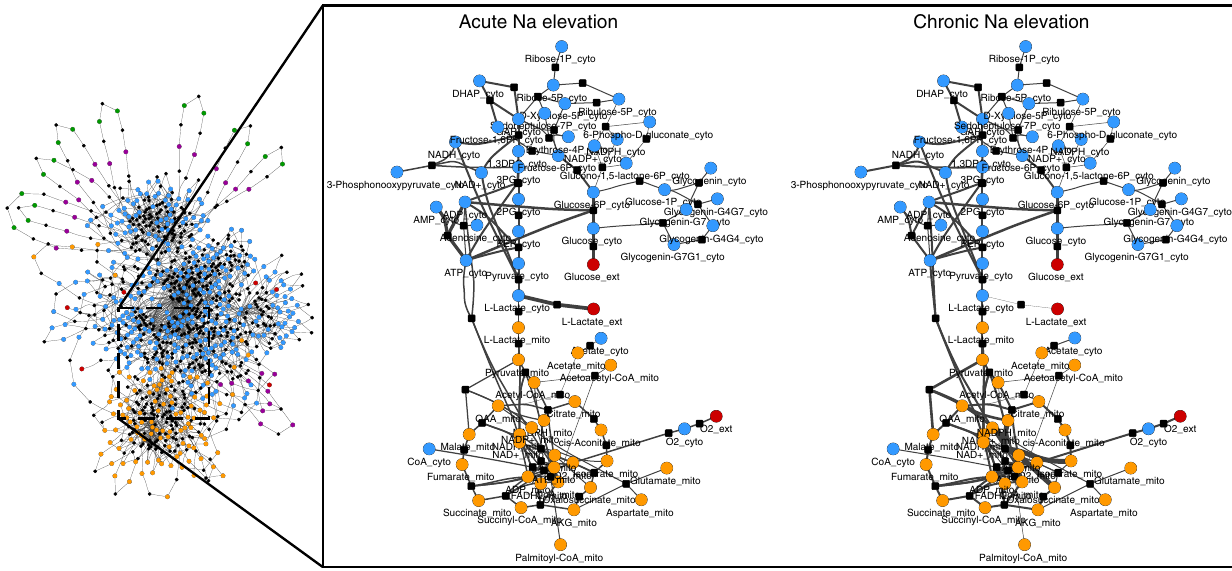
Fig. 6 CardioNet in silico metabolic fl ux changes in response to acute and chronic Na i elevation. Graph denotes estimated fl ux distribution in response to acute and chronic Na i elevation. The coloured nodes represent metabolites assigned to fi ve different compartments: extracellular space, cytosol, mitochondria, microsome, lysosome. The black square nodes indicate reactions; two reactions are linked by a directed edge indicating the reaction fl ux. The line thickness of each edge is proportional to predicted fl ux rate change. Source data are provided as a Source Data fi